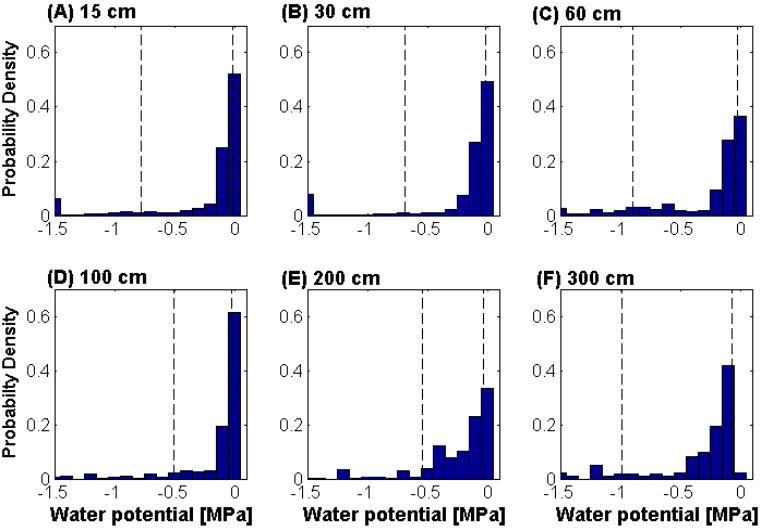
Figure 3. Distribution of soil water potential at different depths at our site during the experiment (summer 2011). The normalized histogram (probability density function, PDF) of half-hourly measurements of soil water potentials (in MPa) is plotted. Each depth is a result from 8 ( A – D ) or 4 ( E , F ) soil moisture probes at different locations. Dashed lines illustrate the 10th and 90th percentiles of the soil moisture